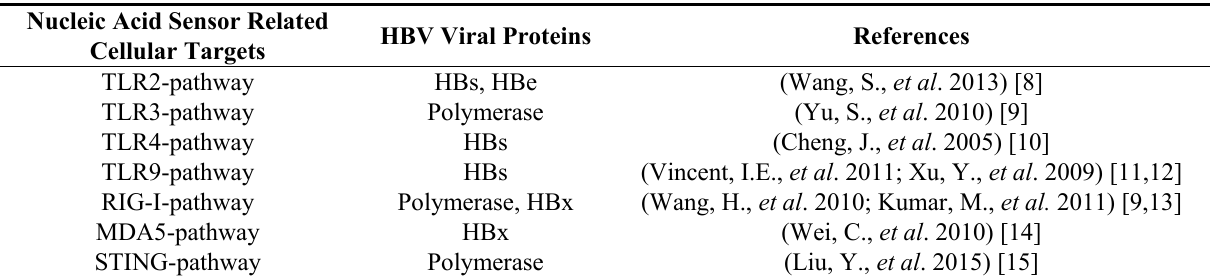
Table 1. Innate immune signaling pathway of varies nucleic acid sensor interfered by the HBV viral